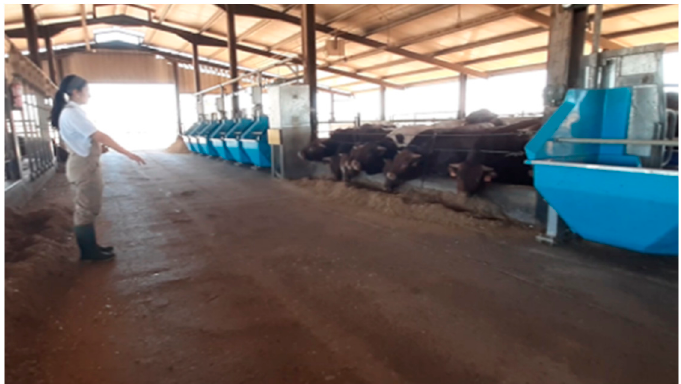
Figure 3. Human approach test at the feed corridor.